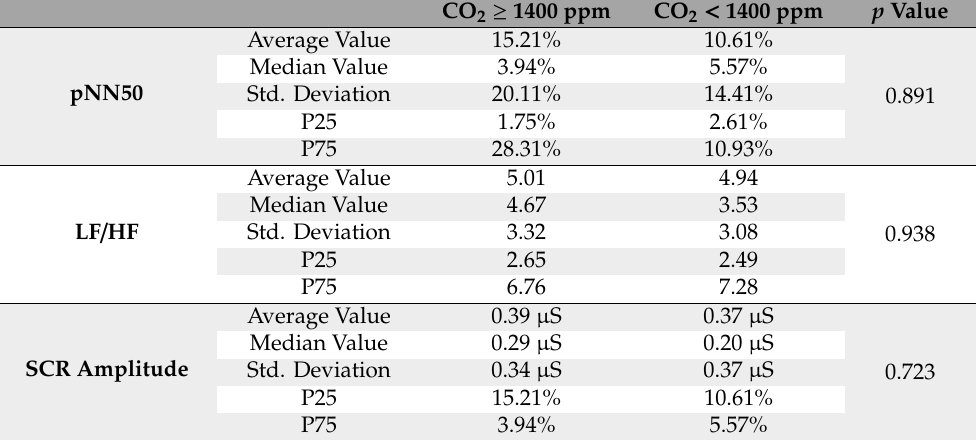
Table 12. Heart rate variability and skin conductivity during driving test grouped by CO 2